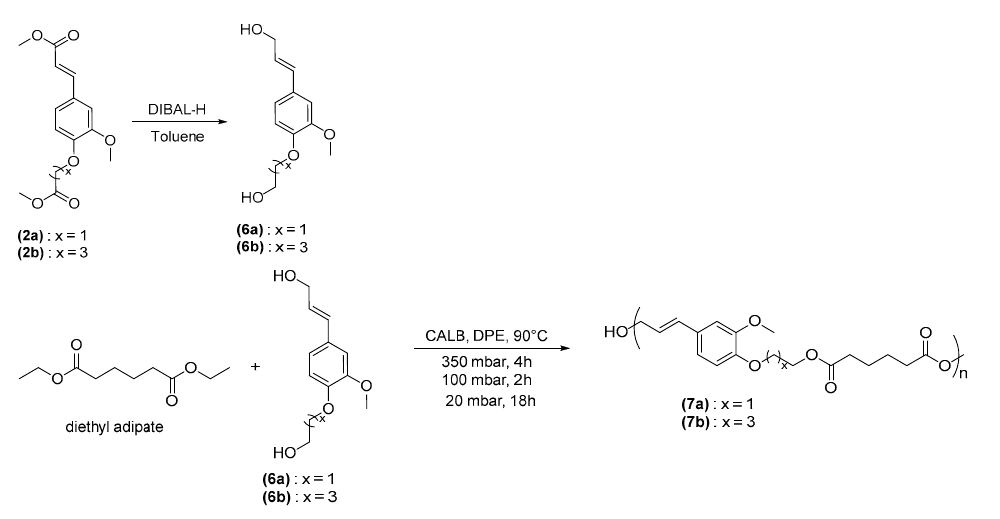
Scheme 4. Synthesis and polymerization of the ferulic-based diols 6a and 6b